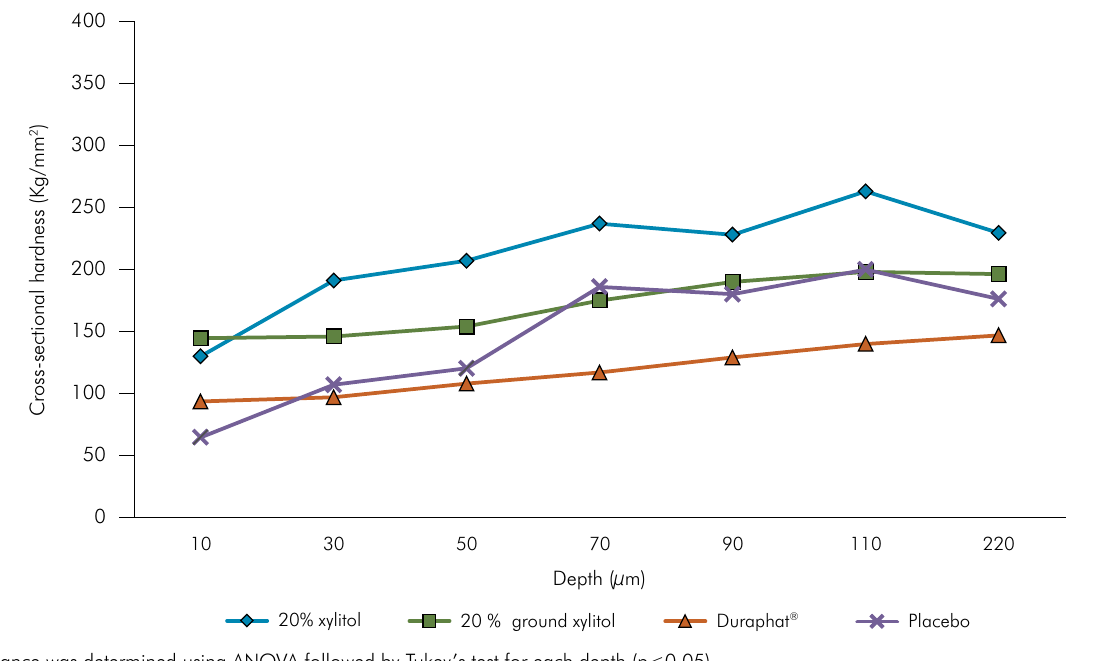
Figure 3. Subsurface hardness (kg/mm 2 ) at the different depths of the experimental groups for the permanent teeth in vitro .